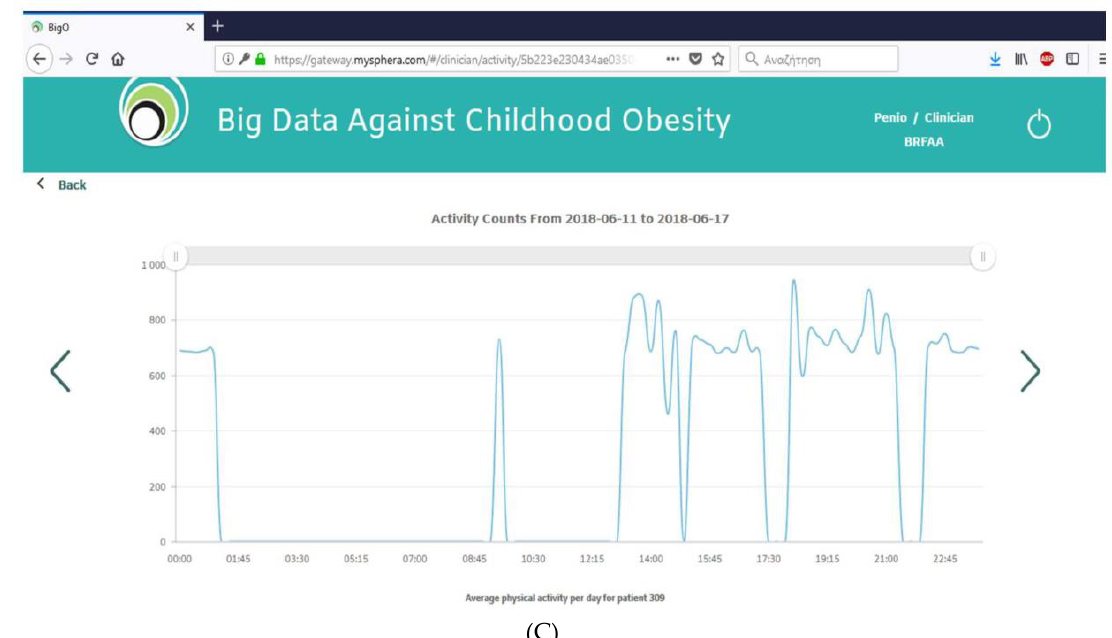
Figure 2. The Big Data against Childhood Obesity Platform: ( A ) decrease in weight and body mass index (BMI); ( B ) photographs of foods consumed; ( C ) the average physical activity per day per week. Phase 1, which has also been completed, included 750 participants (372 males, 378 females) aged